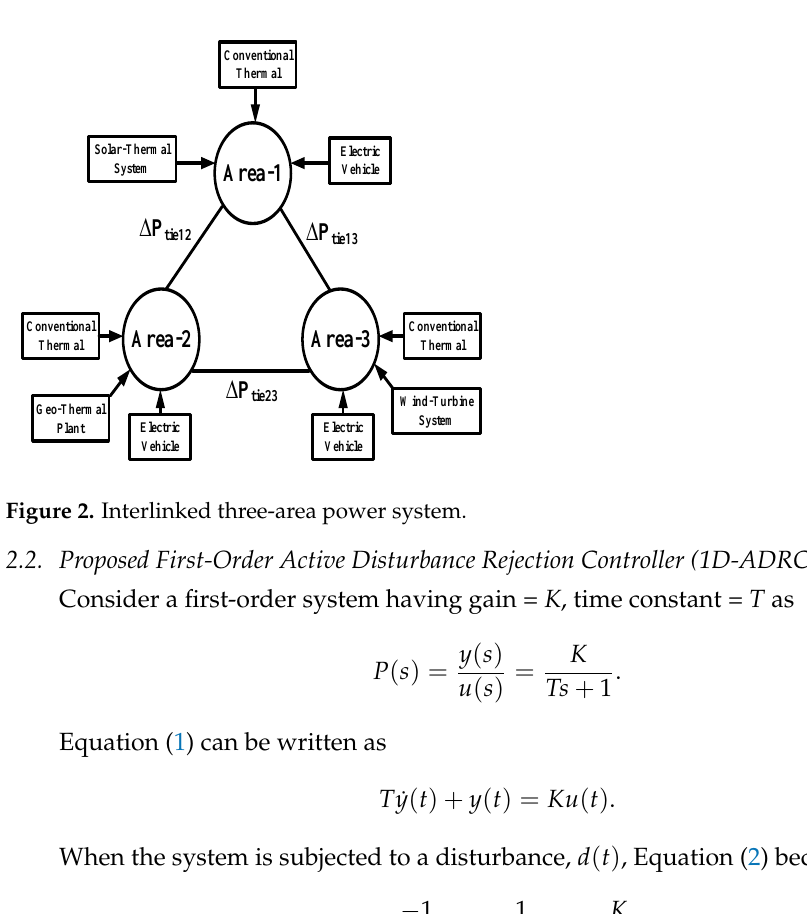
Figure 1. SLD of IEEE-39 bus system.